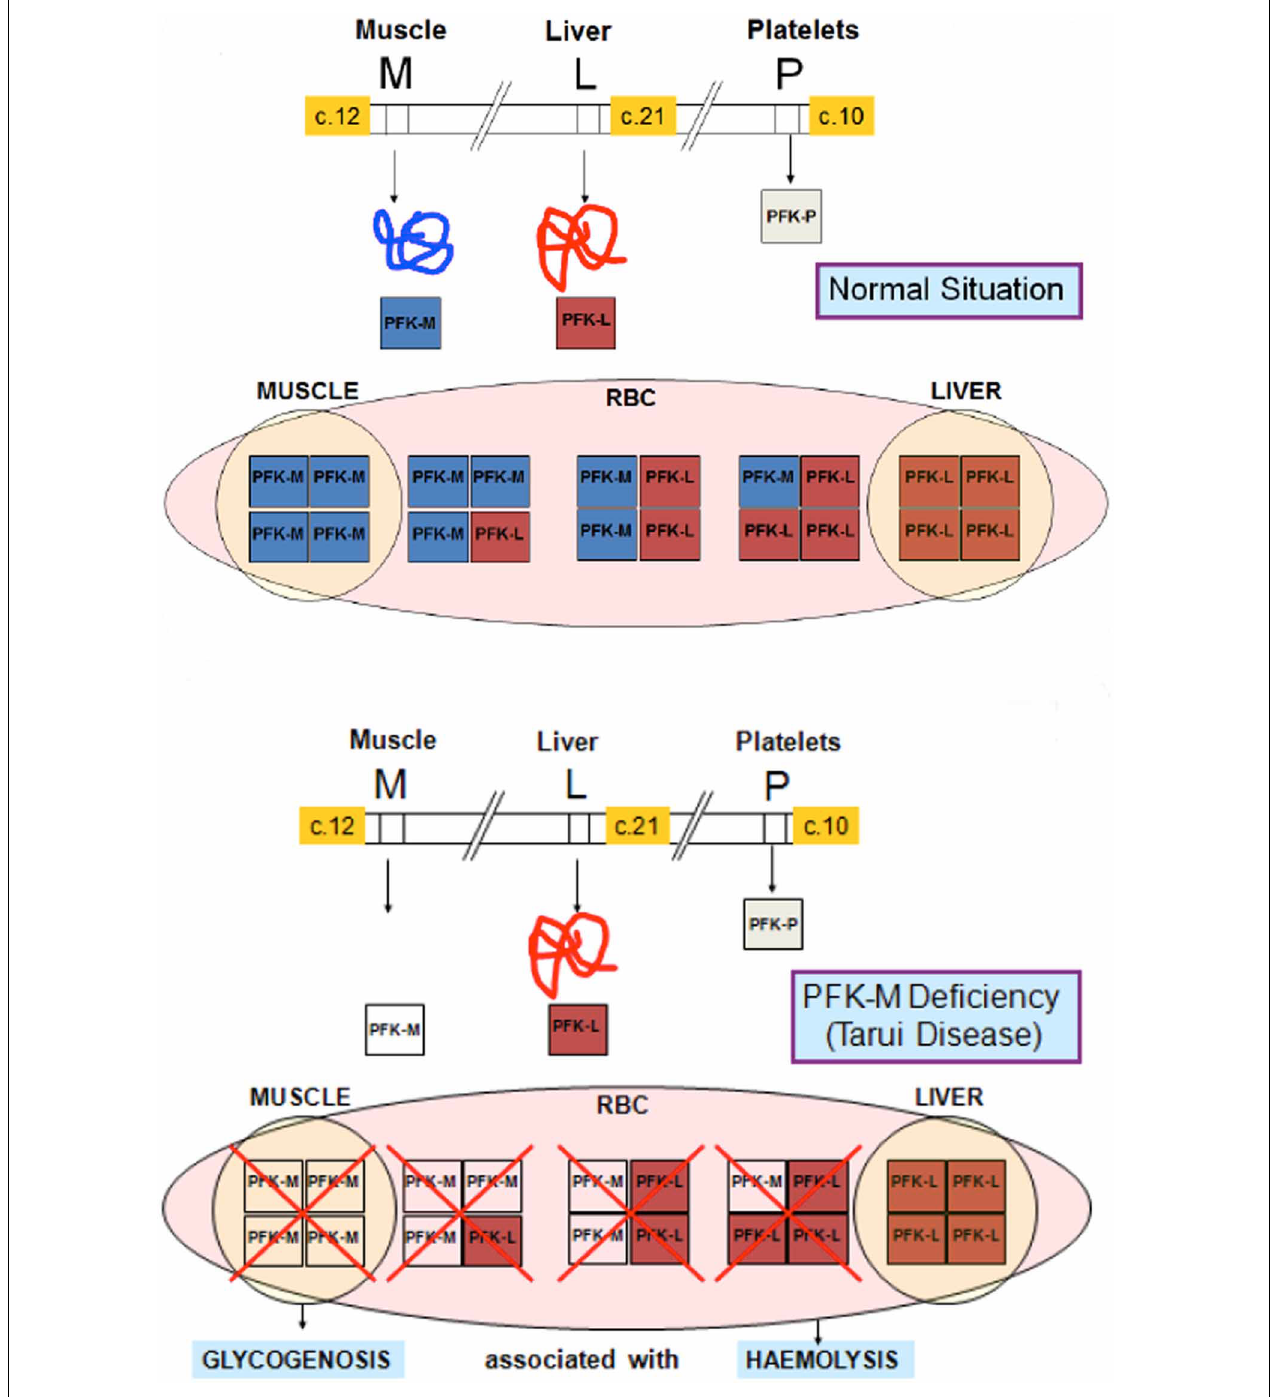
FIGURE 3 | Molecular basis of PFK deficiency. In classic Tarui disease, the genetic defect involves theM isoform of PFK enzyme, resulting a severe enzyme deficiency in muscle. Erythrocytes that normally have two 5 (c.237 + 1G > A) accounts for 68% of mutant Ashkenazi alleles, and a single base deletion in exon 22 (c.2003delC) accounts for about 27% of mutant Ashkenazi alleles (Raben and Sherman, 1995). The here described homozygous patient is the first Spanish